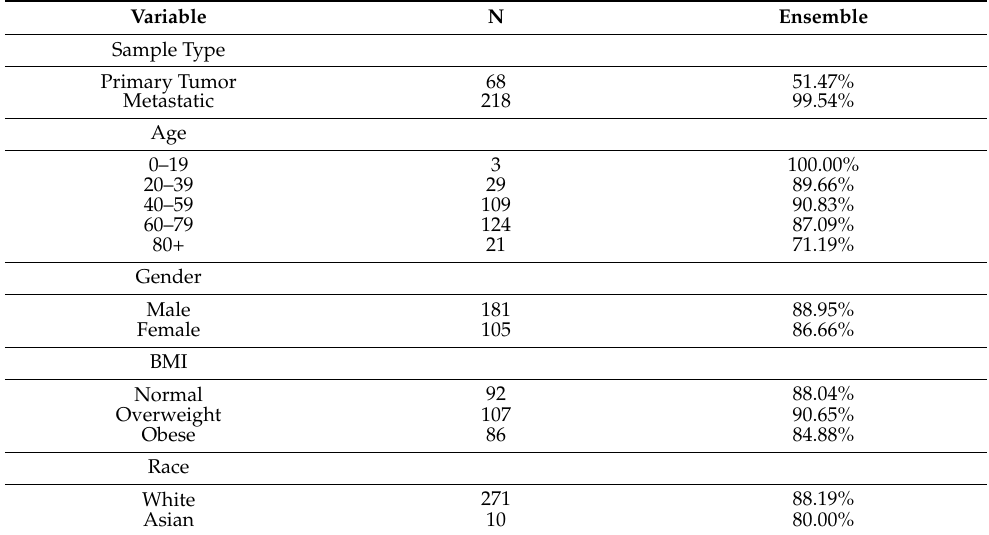
Table 7. Performance accuracy of the models to examine implicit bias in training data set.